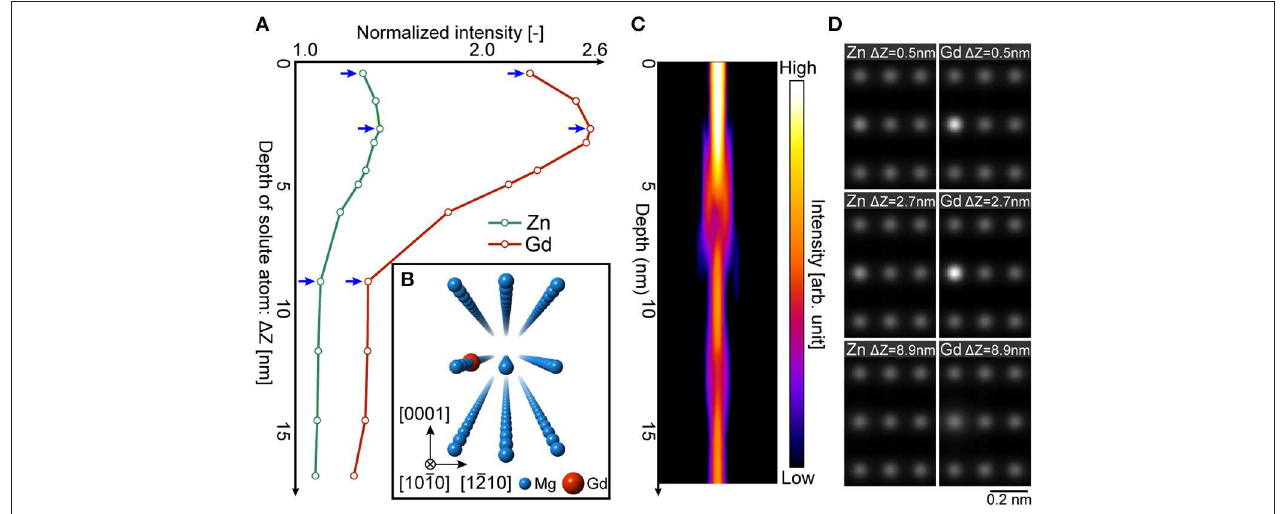
FIGURE 2 | (A) Simulated HAADF-intensity profiles of the Mg atomic columns containing single solute atom, showing solute depth-position dependent change; green and red profiles for Zn and Gd, respectively. The simulations are performed for the hcp -Mg crystal projected along [10 ¯ 10] hcp , the model of which is schematically drawn in (B) , where the single Zn or Gd atom is placed at the left-middle column with a certain depth position. Simulation conditions are; spherical aberration coefficient Cs = 0mm, specimen thickness = 16.8nm, defocus = 0nm, beam-convergent semi-angle α = 22 mrad. (C) Incident electron-beam propagation along the [10 ¯ 10] hcp direction of the hcp -Mg crystal, calculated with the above conditions. (D) Representative simulated HAADF images for the different solute Zn/Gd depth positions, each of which corresponds to the depth at those indicated by arrows in (A)